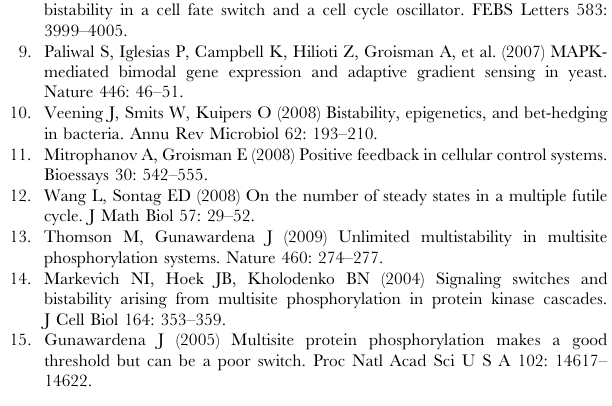
Table S1 Parameter set for Figure 4A and 4B. Under these parameter values the system MA-S is bistable but MA-NS is not.